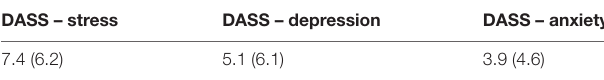
Table 2 | Mean (sD) Dass scores in the classifier-development group.